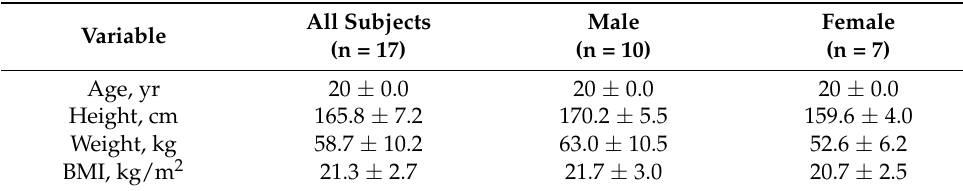
Table 1. Subjects’ characteristics.